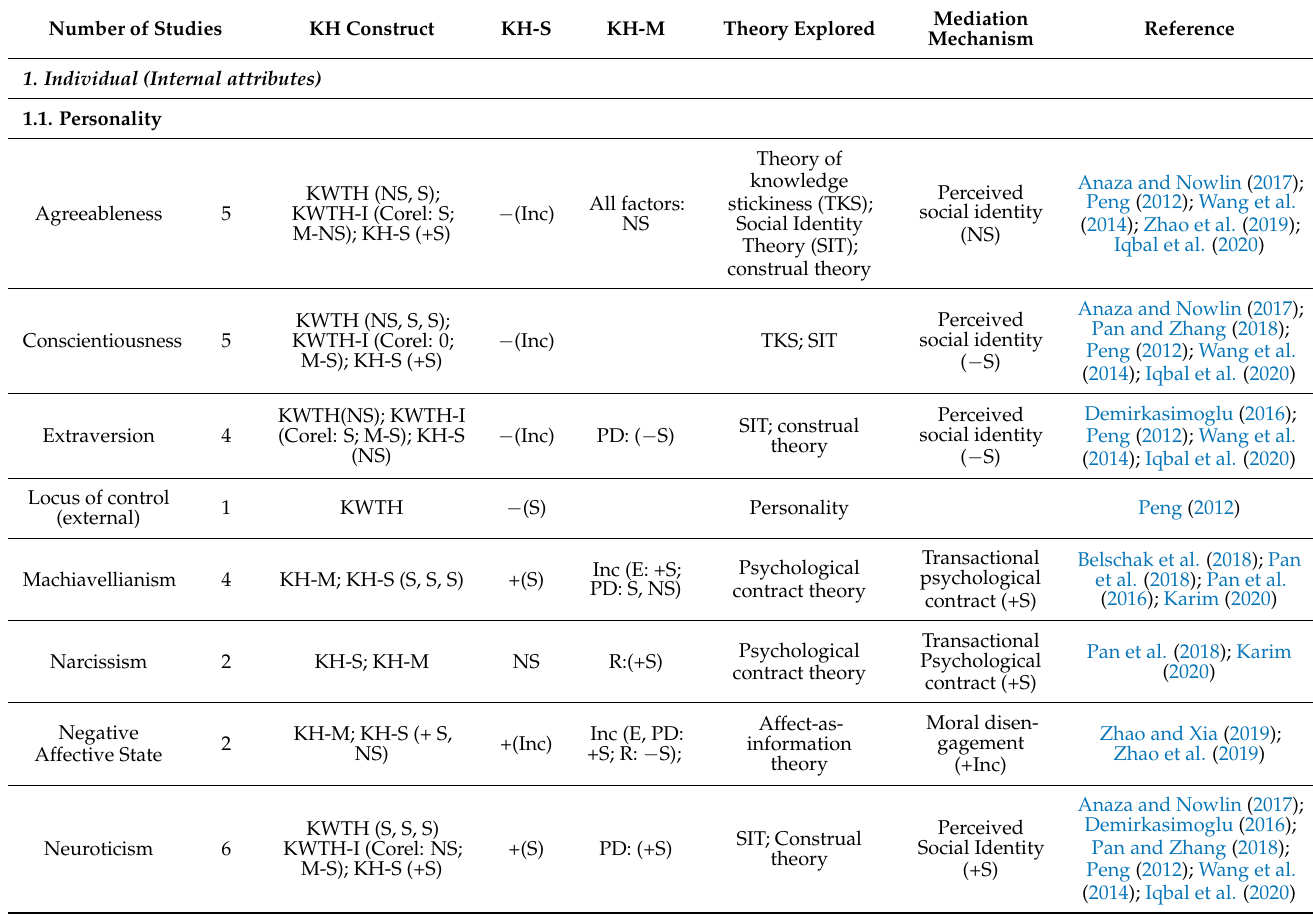
Table A2. Summary of the variable categories explored in previous studies as antecedents of